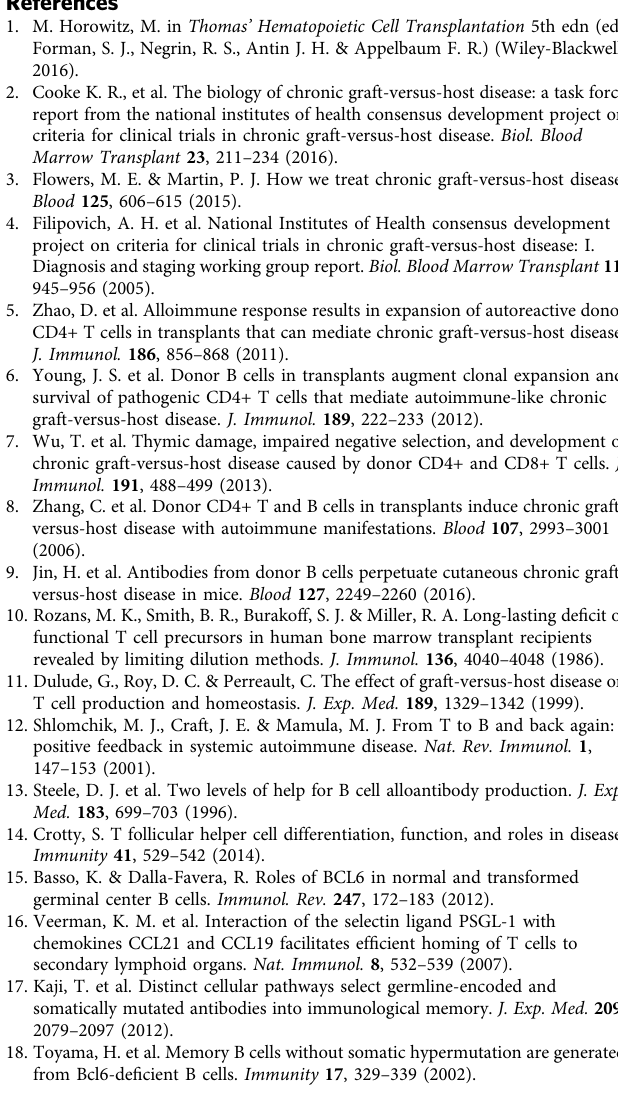
1 lo CD4 + cells were sorted with a 6-laser Arial III immunocytometry system (DakoCytomation, Fort Collins, USA) and used for intracellular cytokine staining, RNA-seq analysis and in vivo adoptive transfer experiments. The gating strategies were shown in Supplementary Fig. 25. In vivo anti-ICOS treatment . Anti-mouse ICOS (7E.17G9) was purchased from Bio-X cell (West Lebanon, USA, #BE0059). The in vivo anti-ICOS treatment was performed according to previous report with modi fi cation 28 . The treatment started on the day of transplantation, and recipients were injected i.p. with 200 µ g/mouse anti-mouse ICOS or isotype control (rat IgG2b, #BE0090) every other day until 45 days after transplantation. Statistical analysis . Survival in different groups was compared using the log-rank test with the program GraphPad Prism, version 6.0 (GraphPad Software, San Diego, CA). Two-way ANOVA was used for comparing body weight changes and cutaneous cGVHD score in different groups. Unpaired two-tailed Student ’ s t test was used to determine signi fi cant differences between two experimental